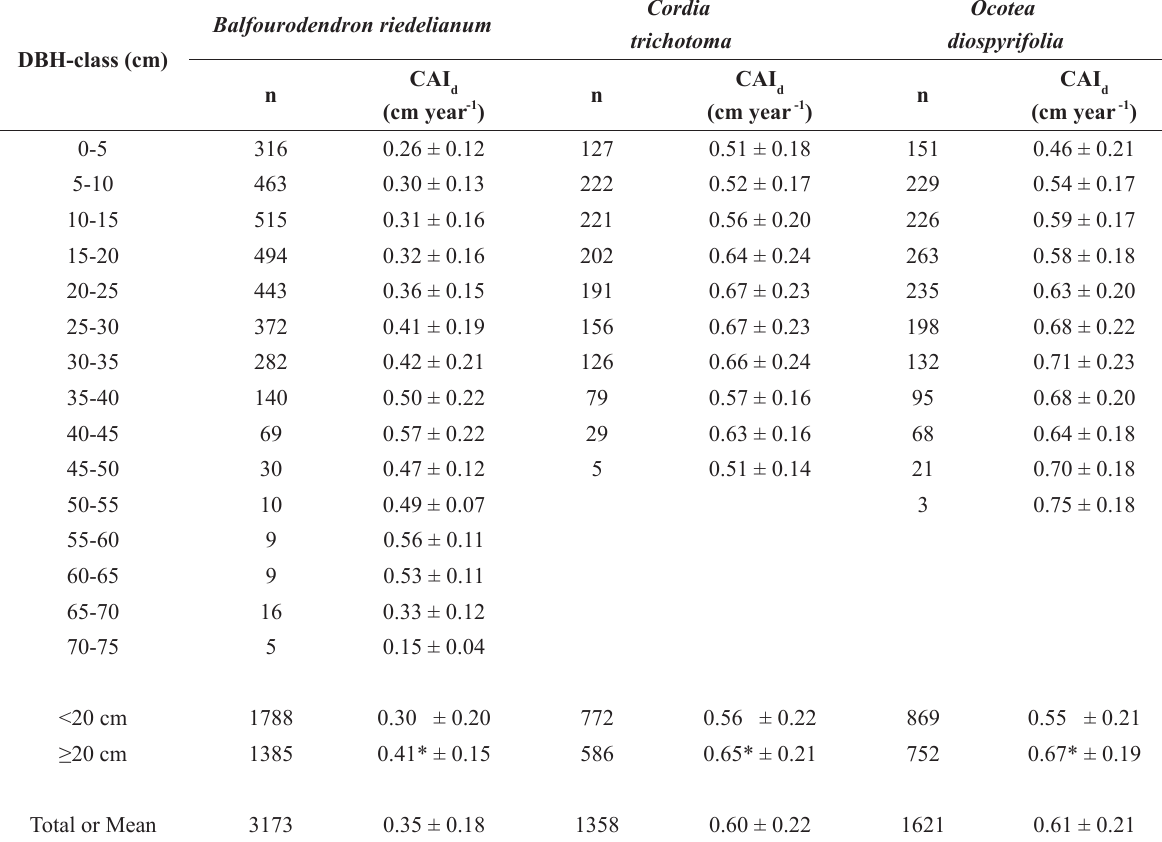
Measured rings (n) and mean for current annual increment in diameter (CAI ) grouped by DBH-class of 5 and 20 cm for d three forest species in the Iguaçu National